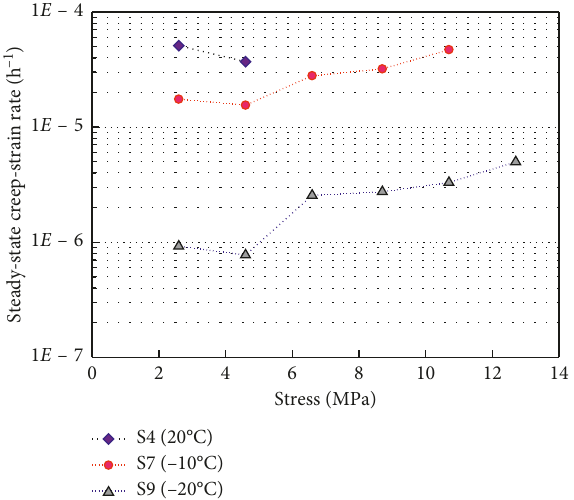
Figure 10: Steady-state creep-strain rate versus stress.